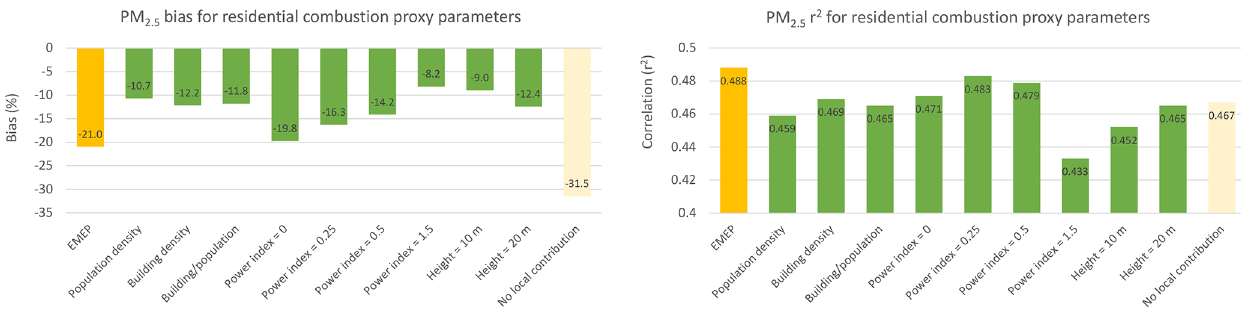
Figure 14. Change in bias and spatial correlation (coefficient of determination r 2 ) for PM 2 . 5 as a result of changes in the residential combustion proxy. A lower power-law index gives less weight to the population redistribution, and a higher power-law indices give more weight. “Building/population” is the building density masked by population data. See text for